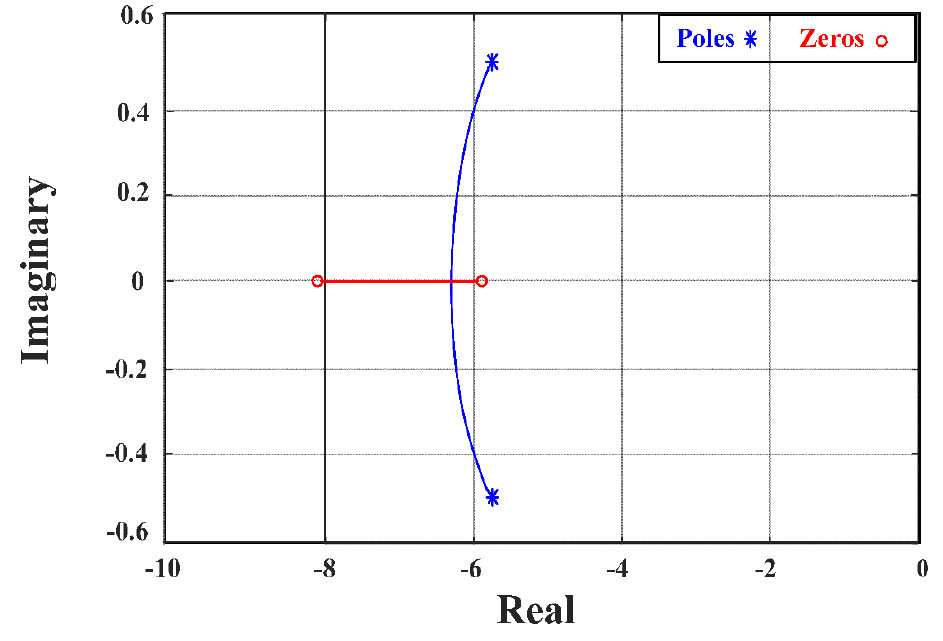
Figure 6. Allocation of dominant pole-zero of G R 11 .